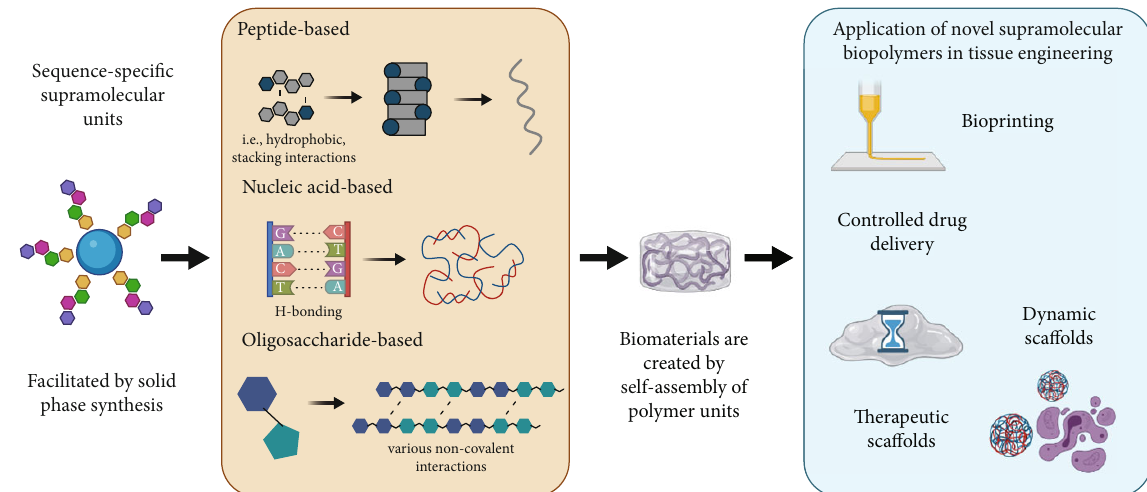
Figure 1: The technology of solid-phase synthesis eased the generation of sequence-speci fi c units for supramolecular assemblies. These sequence-speci fi c units interact with each other by varied noncovalent interactions, which leads to the assembly of nano- and microscopic structures that develop into macroscale sized biomaterials, such as hydrogels. These supramolecular assemblies can be used as novel biopolymers for tissue engineering, as their properties allow them to be used as bioinks, as carrier for controlled drug delivery, and as dynamic and therapeutic sca ff